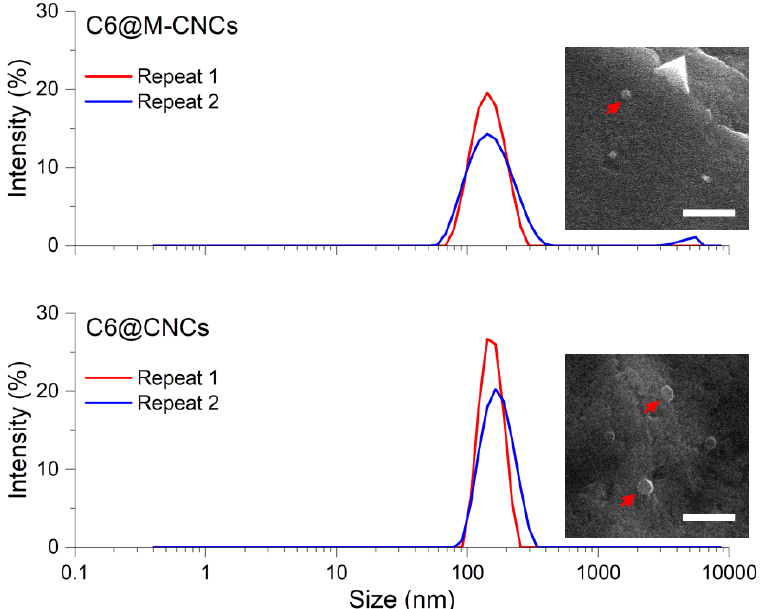
Figure 4. Size determination of the C6@CNCs and C6@M-CNCs was performed with DLS and scanning electron microscopy. The mean hydrodynamic diameters of the C6@CNCs and C6@M-CNCs, as determined by DLS, were 160 nm and 140 nm, respectively. Results from two in- dependent repeats are shown. The scanning electron microscopy images are provided as insets where red arrows mark individual particles. Scale bars denote 1 µm.